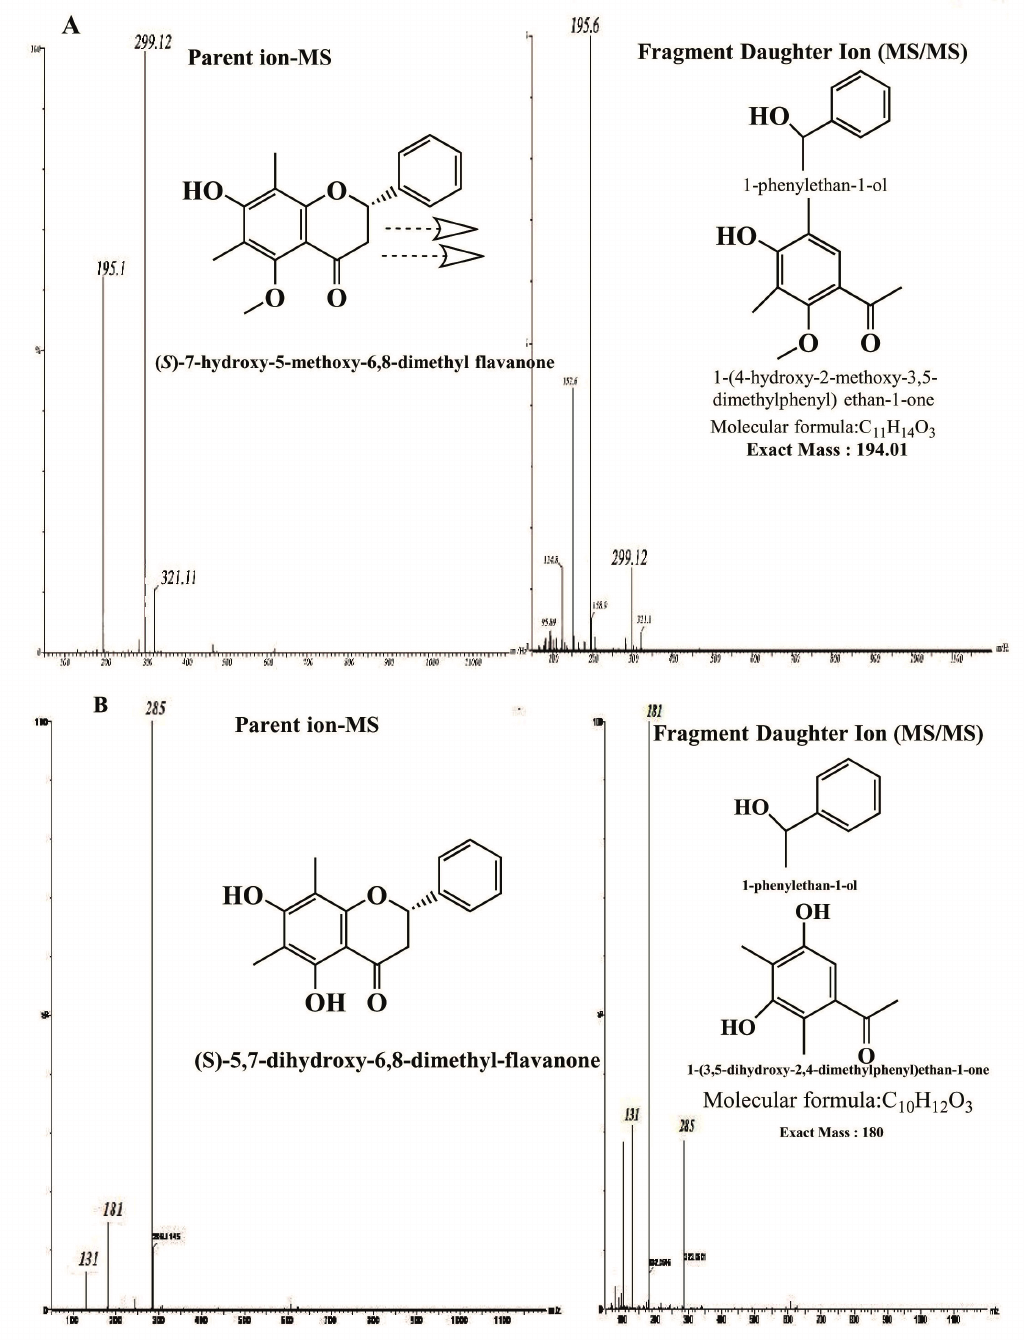
Figure 4. LC-EIMS-spectra of compounds: (2 S )-7-Hydroxy-5-methoxy-6,8-dimethyl flavanone ( A ) and ( S )-5,7-dihydroxy-6,8-dimethyl flavanone ( B ). 13 C-NMR spectrum: 13 C-NMR spectrum of compound ( 1 ) showed signals at δ : C-2 (78.8), C-3 (45.0), C-4 (190.94), C-4a (107.76), C-5 (161.74), C-5-O-CH 3 (60.0), C-6 (107.82), C-7 (160.0), C-8 (112.23), C-8a (157.2), C-1 ′ (139.5), C-2 ′ & C6 ′ (128.29), C-3 ′ & C-5 ′ (125.7), C-4 ′ (128), C-6-CH 3 (7.09) and C-8-CH 3 (7.27) Figure